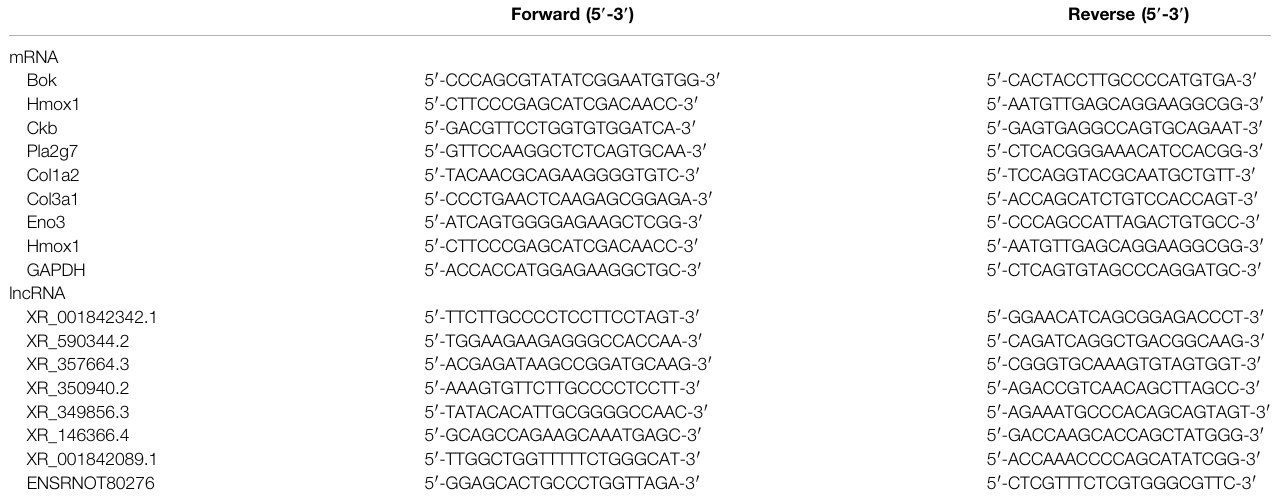
TABLE 1 | List of primer sequences for